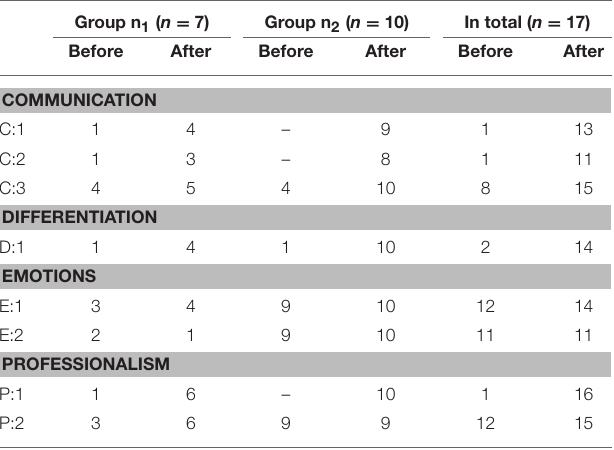
TABLE 2 | Comparison of analyses before and after access to explicit criteria for groups n 1 and n 2